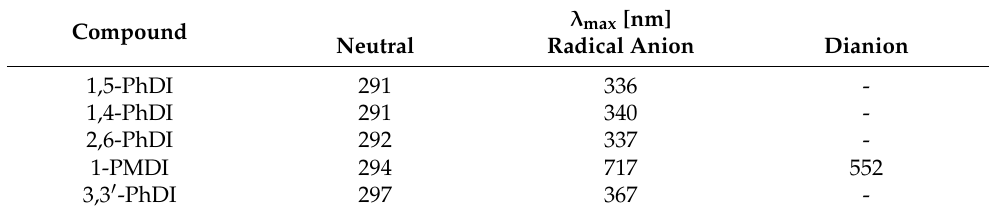
Table 5. UV–Vis spectroscopic data obtained for the studied derivatives dissolved in 0.1 M Bu 4 NPF 6 / Table 5. UV – Vis spectroscopic data obtained for the studied derivatives dissolved in 0.1 M DMF electrolyte in their neutral and reduced Bu 4 NPF 6 /DMF electrolyte in their neutral and reduced states.